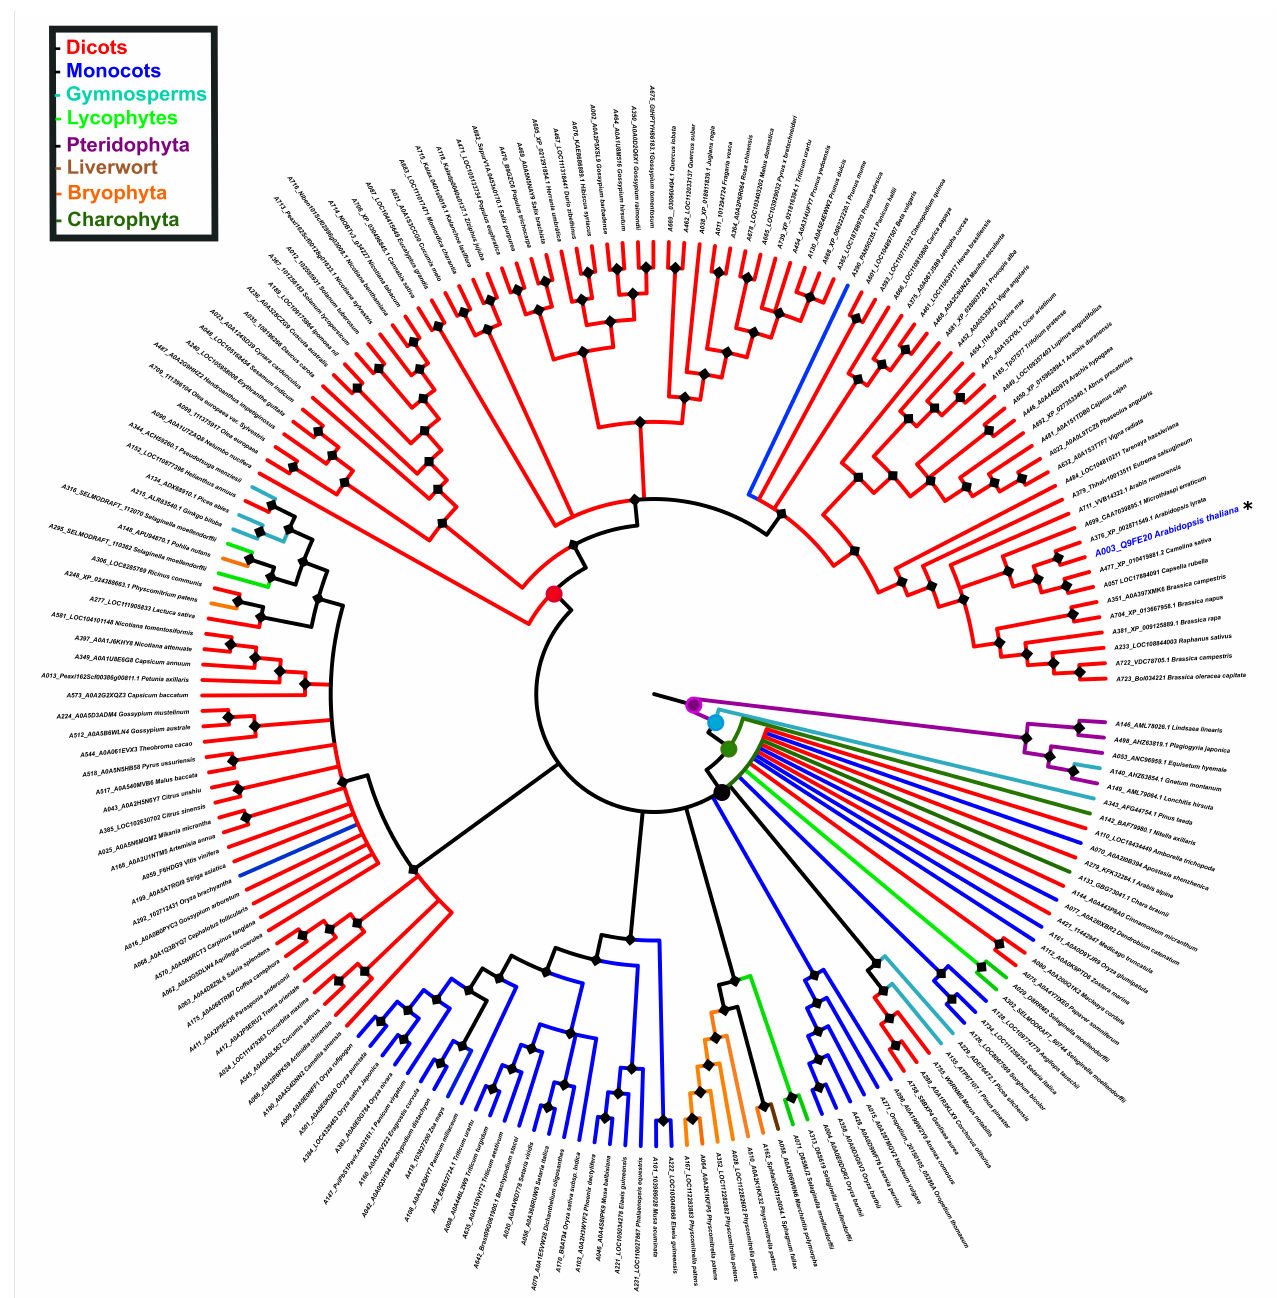
Figure 7. Reconstruction of PBS1 ancestral ortholog sequences in terrestrial plants. The ancestral tree was produced by Bayesian statistics using 182 sequences from monocots (blue), dicots (red), bryophytes (orange), liverwort (brown), lycophyte (light green), gymnosperm (light blue), charophytes (dark green), and pteridophytes (purple). Circles in nodes indicate mainly ancestors. Position of Arabidopsis in the tree is indicated with asterisk (*) and blue color. The analysis of PBS1 ancestral sequences was obtained with the Mesquite software (http://www.mesquiteproject.org, accessed on 6 February